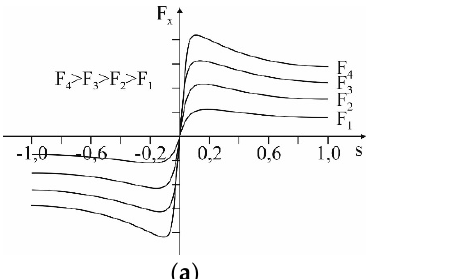
S —static radius.